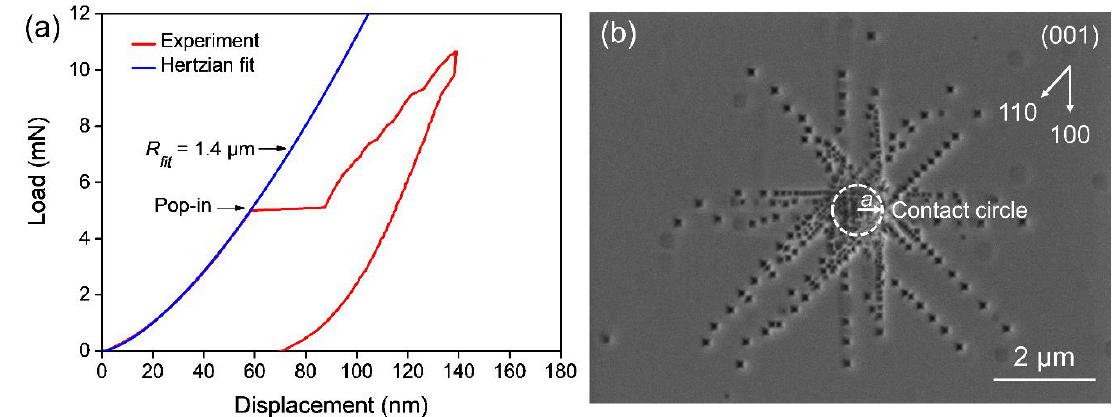
Figure 3. ( a ) Indentation load-displacement curves with pop-in event on (001) surface of single crystal SrTiO 3 ; ( b ) SEM images showing dislocation etch pits.